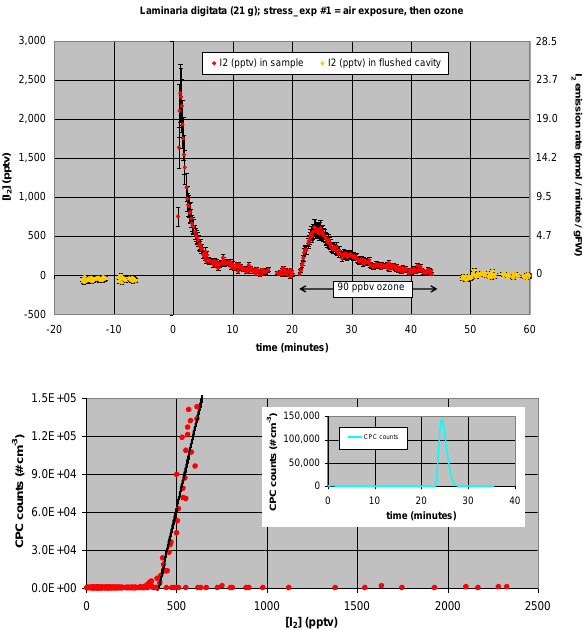
Fig. 5. TimeseriesofI 2 mixingratiosandemissionratesfor L.digitata stressexperiment#1. Ozonewasscrubbedfromtheairflowforthe Fig. 5. Time series of I 2 mixing ratios and emission rates for L. dig- first20minutesoftheexperiment,afterwhich ∼ 90ppbvofozonewasadded. Theinsettothelowerpanelshowstheparticleformationevent itata stress experiment #1. Ozone was scrubbed from the air flow observedco-incidentwiththesecondozone-inducedI 2 emissionburst. Thelowerpanelalsoshowsacorrelationplotofparticlecountsversus for the first 20 minutes of the experiment, after which ∼ 90ppbv I 2 mixingratio,withtheheavyblacklinebeingalinearfittotheparticledataduringtheozone-inducedemissionburst. of ozone was added. The inset to the lower panel shows the par- ticle formation event observed co-incident with the second ozone- induced I 2 emission burst. The lower panel also shows a correlation plot of particle counts versus I 2 mixing ratio, with the heavy black line being a linear fit to the particle data during the ozone-induced emission burst.